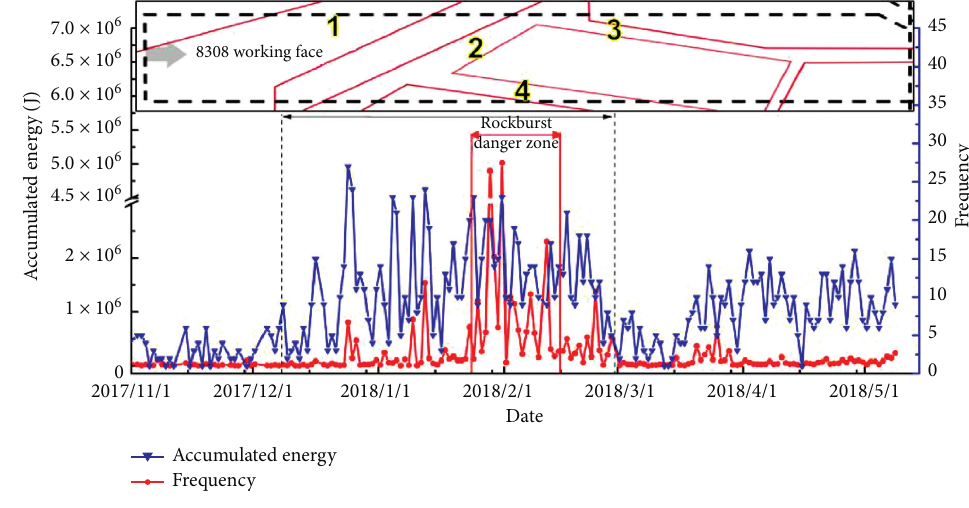
Figure 12: Time series variation of microseismic energy frequency.